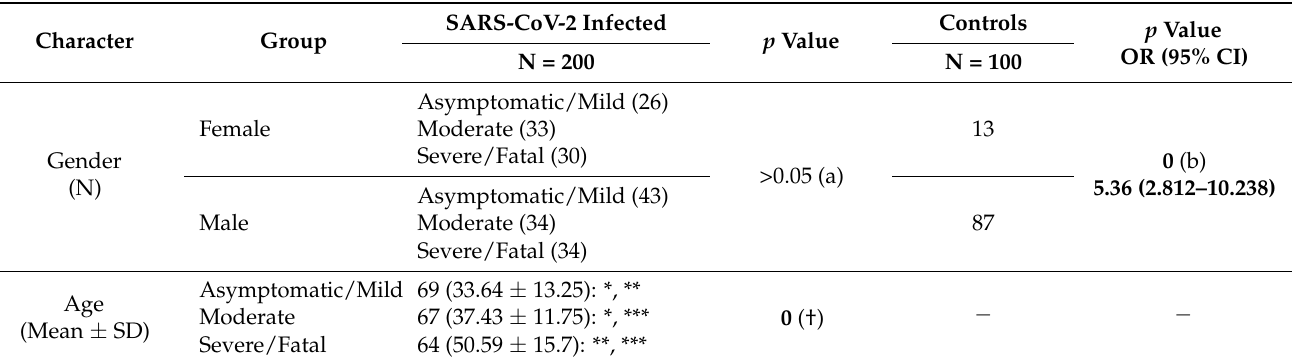
Table 2. Demographic characteristics of the studied